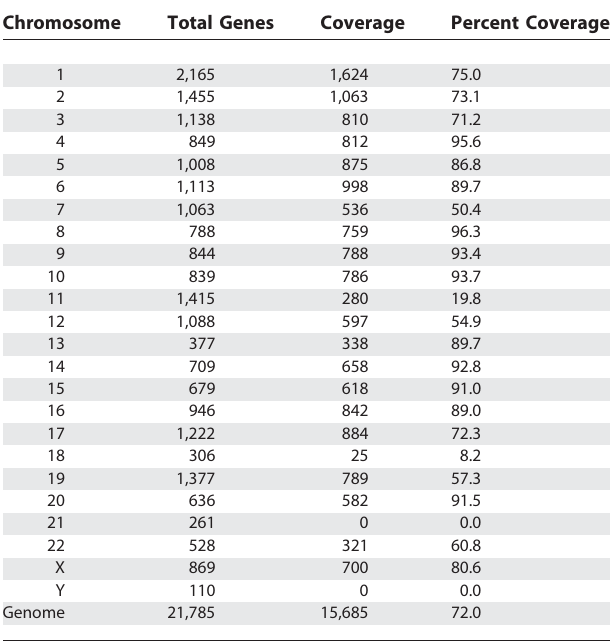
Table 2. Distribution of the Human Genome’s Tetra-Paralogons by Chromosome under the Most Permissive Model for Signal Detection